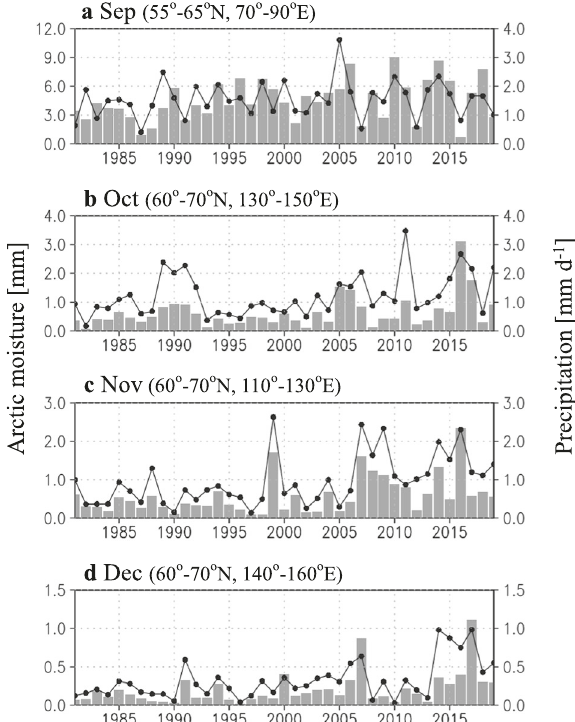
Fig. 5 Historical changes of Arctic moisture. Interannual variations of maximum daily Arctic moisture content (bar and left axis, mm) and fraction of precipitation originated from the Arctic Ocean (line and right axis, mm day − 1 ) averaged over a western Siberia in September and b – d eastern Siberia during October – December. The domain used for area averaging is indicated in each panel. The precipitation fraction was computed by assuming that the rate of Arctic moisture against precipitable water vapor is also retained for